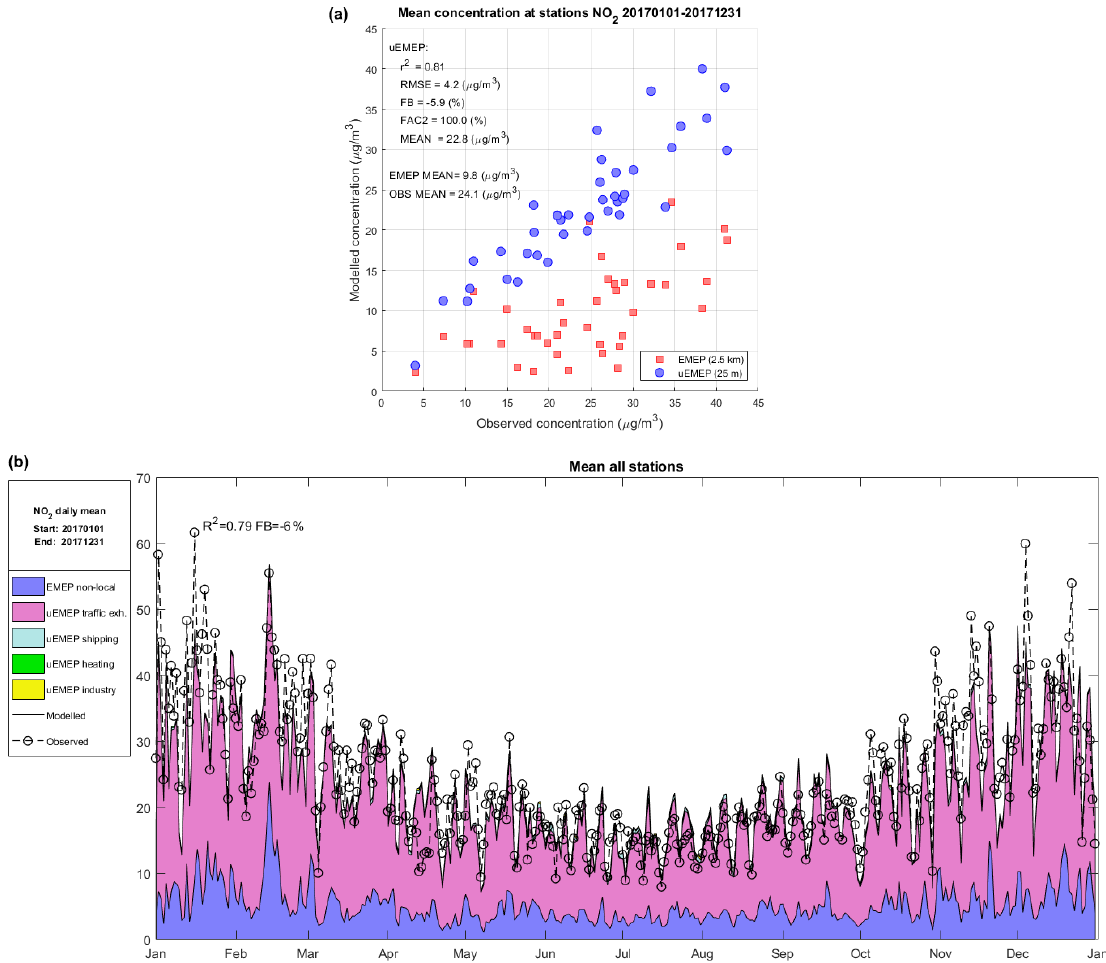
Figure 9. (a) Scatter plot comparison of modelled and observed NO 2 for annual average concentrations at each station. Shown are the results for both uEMEP and EMEP. Comparative statistics are shown for the uEMEP calculation. EMEP and observed means are also included. (b) Daily mean temporal profile averaged over all stations. Source contributions are shown for the temporal modelling results along with the EMEP 2.5km calculation (EMEP4NO). In total, 36 stations are used in the